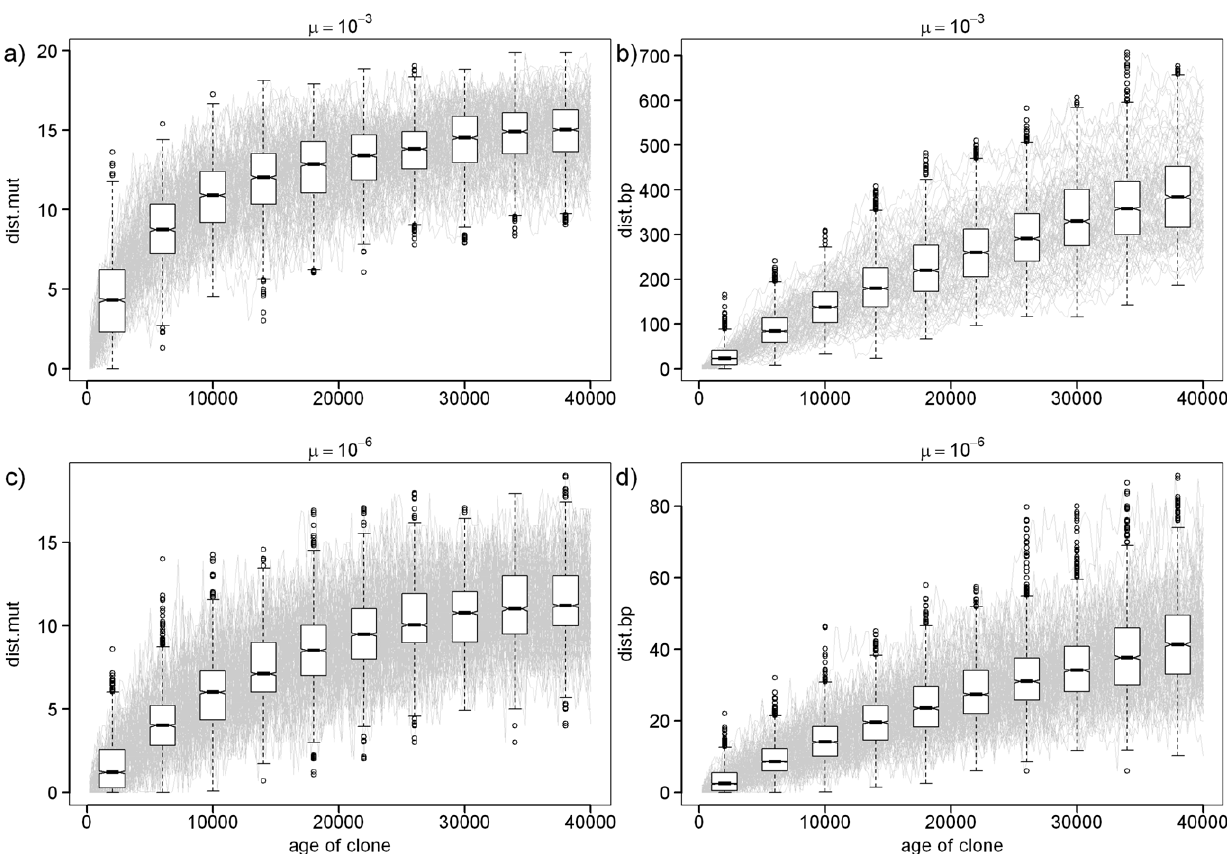
Figure 4. The plots of dist.mut and dist.bp values as a function of true age. Each gray line tracks the evolution of one clonal lineage over the time. Simulations are shown for the 2 values of mutation rate ( m ) under SSM mutation model. At selected times, we represent the boxplots showing the median of simulated values of dist.mut and dist.bp . as well as first and third quartile; whiskers represent 1.5 times the interquartile range.